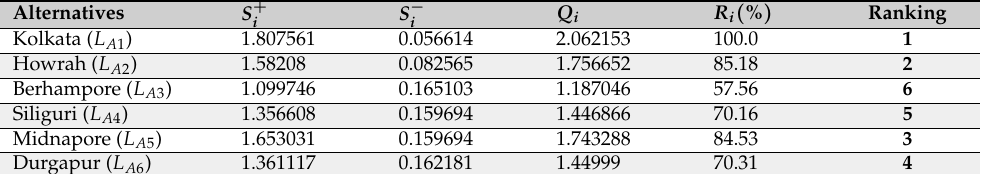
Table 19. Alternatives ranking and their adjacent data by using the NCOPRAS method.